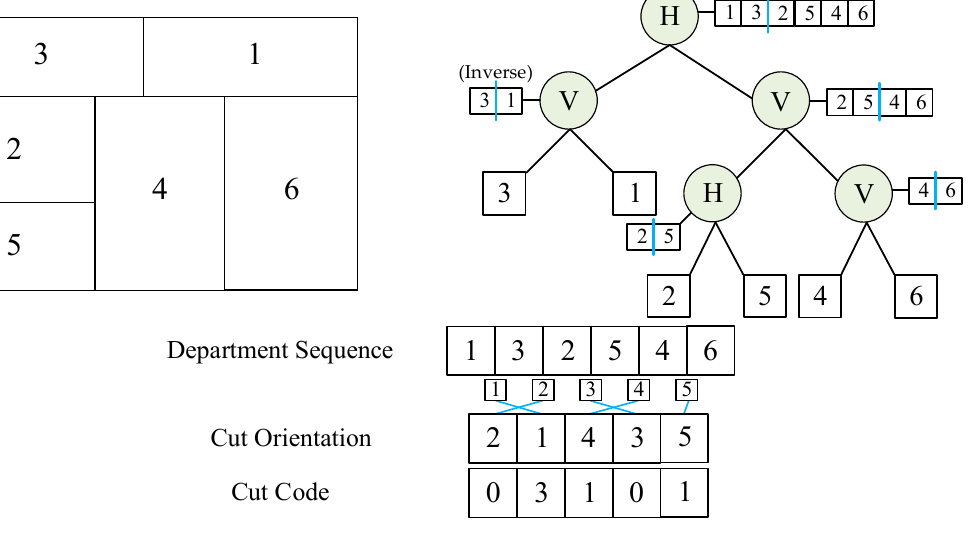
Figure 5. Slicing tree encoding scheme.